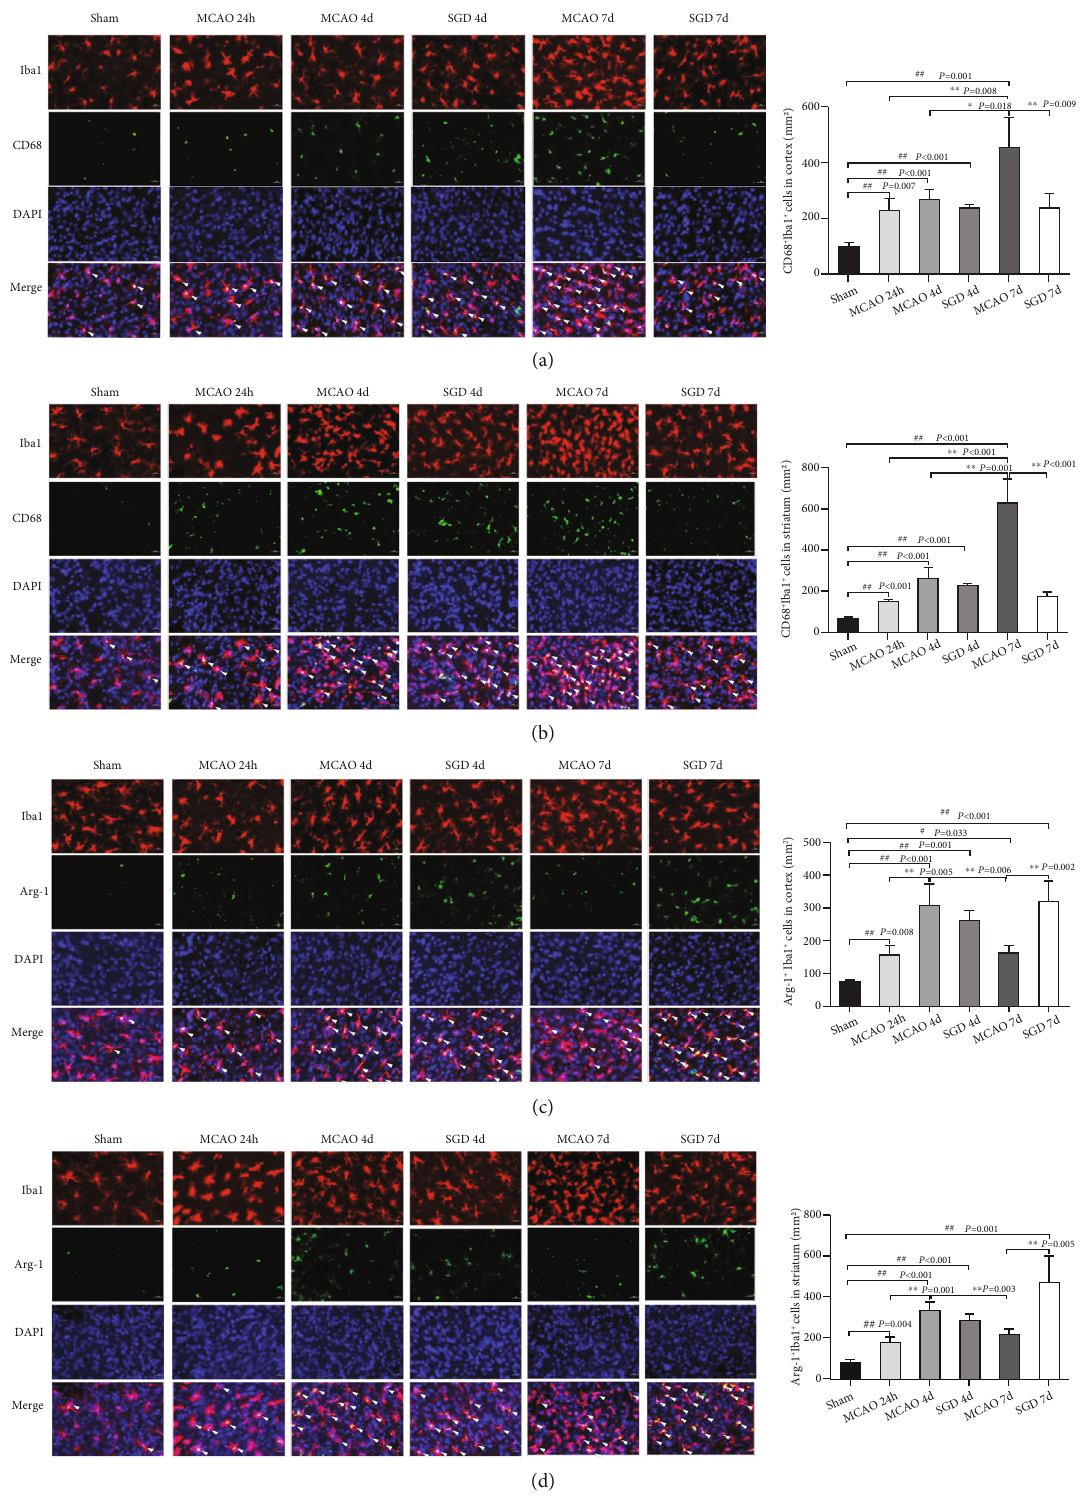
Figure 4: SGD boosted microglia polarization from M1 to M2 after CI/RP treatment of rats. Double immunostaining ( × 200) for Iba1 and CD68 or Arg-1 was performed in brain sections from the sham, MCAO, and SGD groups at three time points. The white arrows in the merged fi gures indicated double positive cells. (a, b) Representative images of Iba1 (red) and CD68 (green) labeling, followed by stained with DAPI (blue) in the cortex (a) and striatum (b), and statistical results were presented on the right side. (c, d) Representative images of Iba1 (red) and Arg-1 (green) labeling, followed by stained with DAPI (blue) in the cortex (c) and striatum (d), and quantitative analysis of double-positive cell counting were listed on the right side. Bar = 20 μ m for all images, n = 3 for each group. # P < 0 : 05 , ## P < 0 : 01 vs. sham; ∗ P < 0 : 05 , ∗∗ P < 0 : 01 vs.